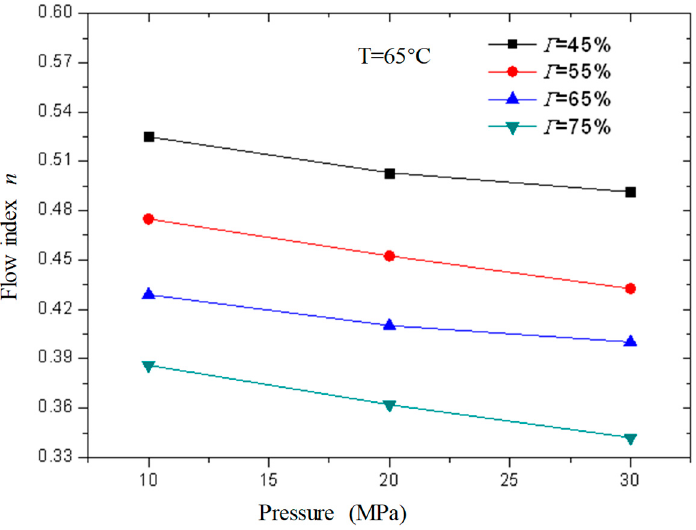
Figure 17. Variation curve of flow index n of foam gel fracturing fluid with pressure under foaming.